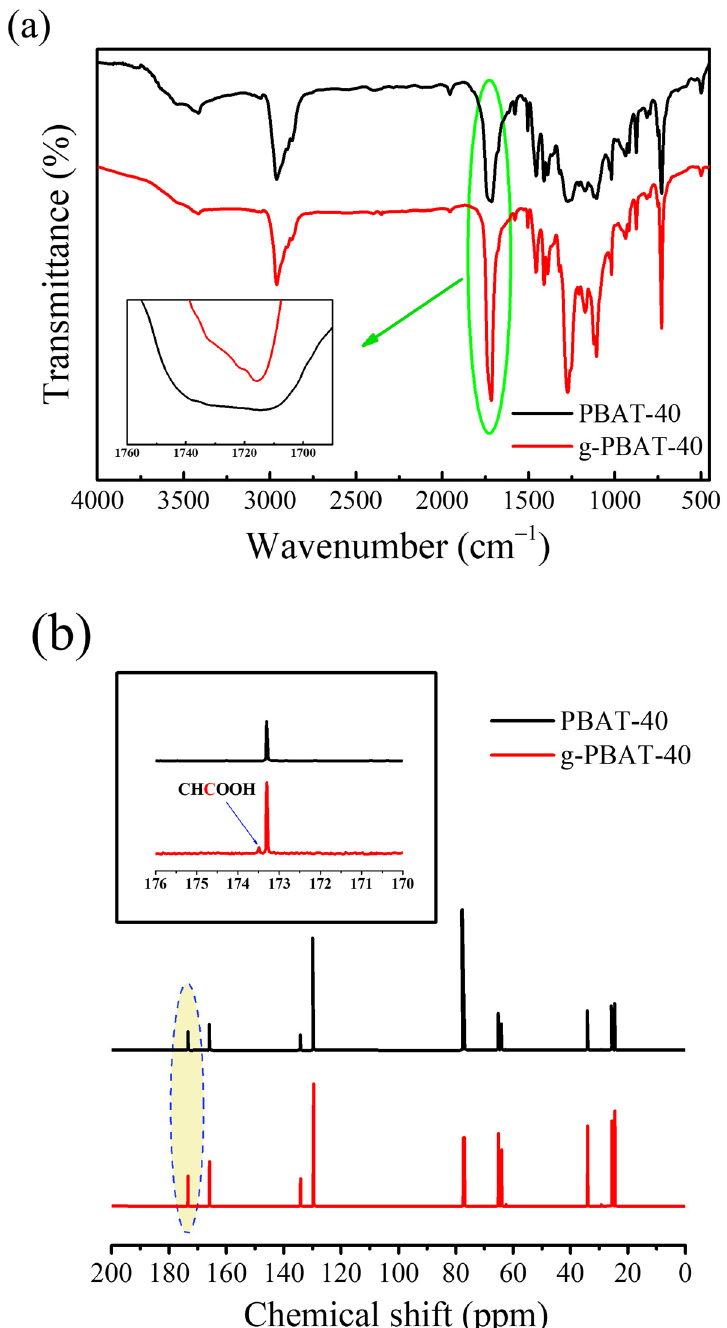
Figure 3. ( a ) FTIR and ( b ) 13 C–NMR spectrum of the PBAT-40 and g-PBAT-40 copolyesters.